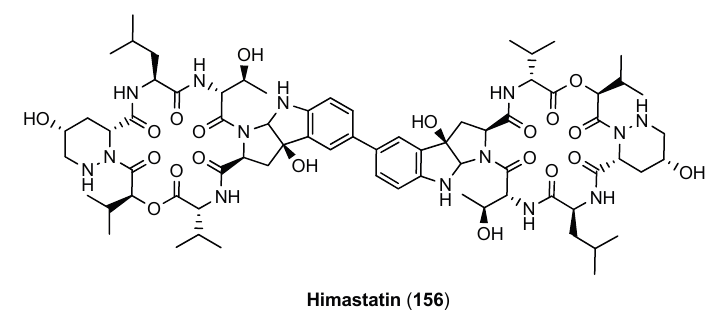
Figure 15. Structure of himastatin ( 156 ).